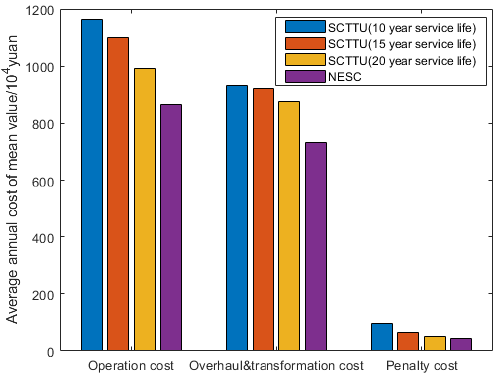
Figure 6. Average annual cost comparison of three costs between NESC and SCTTU.